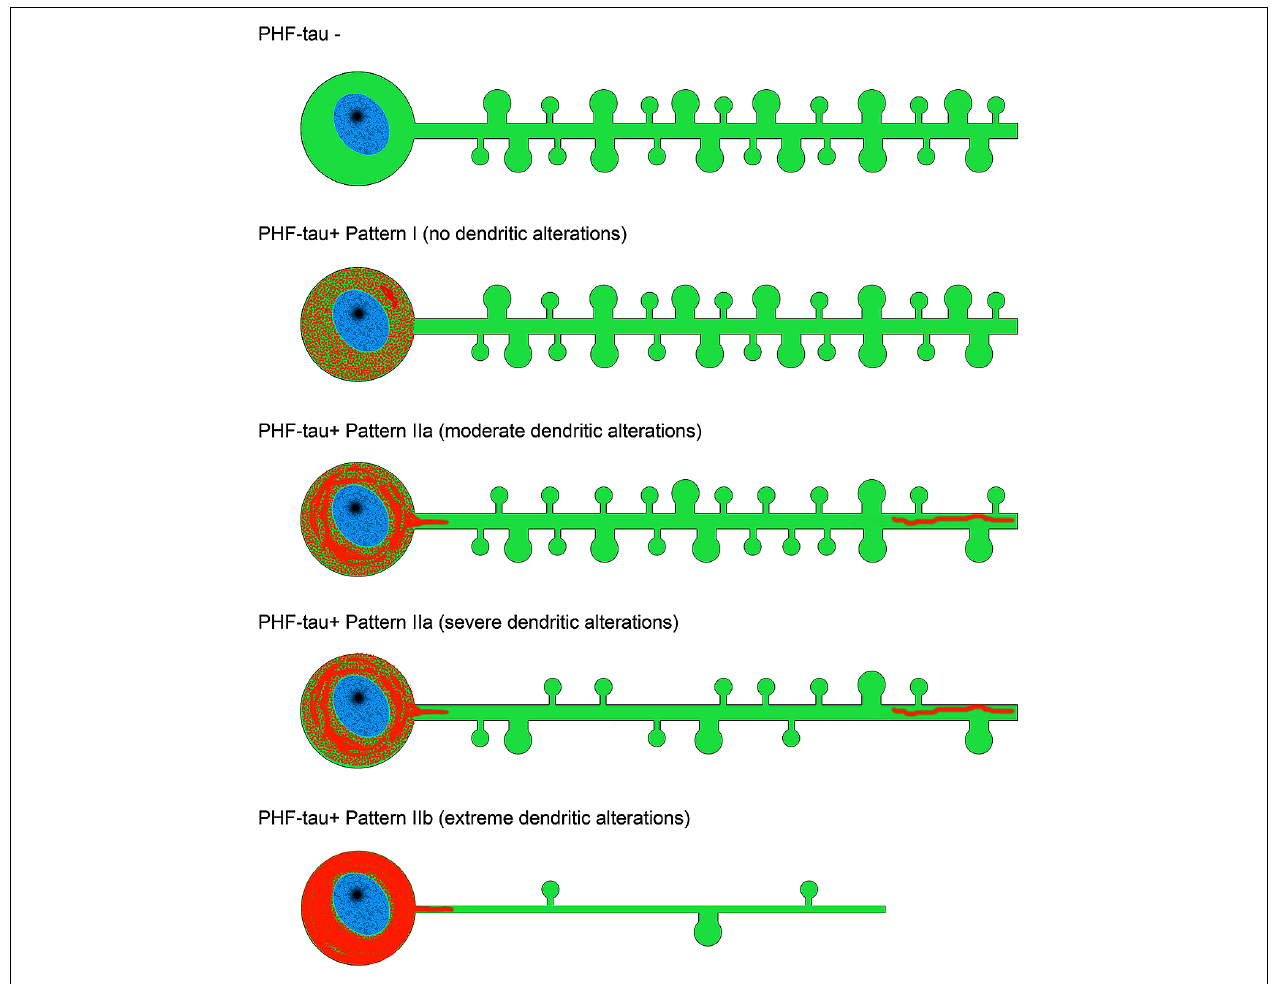
FIGURE 8 | Scheme representing the changes to dendrites of LY-injected neurons that showed different patterns of PHF-tau immunostaining. For simplicity, dendritic spines were represented as two types: small and large. Red, phosphotau.Taken from Merino-Serrais etal. (2013).